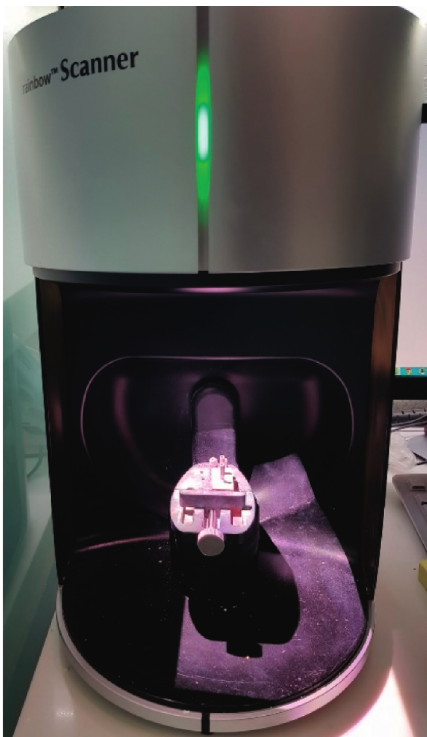
Figure 5: Laboratory scanner.